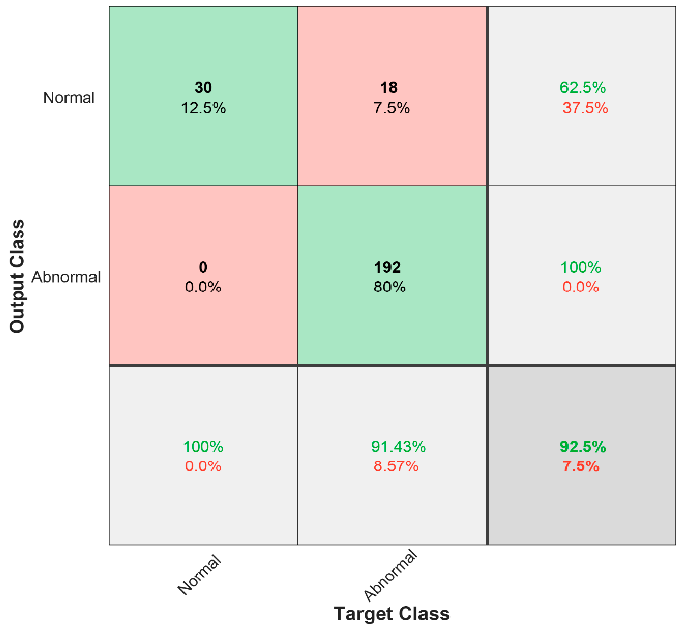
Figure 11. The confusion matrix for two-classes states using PCA-LDA (LLA). Figure 12 also shows the confusion matrix of the presented method for the classification in eight classes. The lower row of the matrix shows the percentages of each disease that were detected correctly (sensitivity). The maximum detection percentage belonged to normal images, and then Huntington and Meningioma came second. However, only 93.3% of Sarcomas were diagnosed correctly. In the end, 92.5% (accuracy) of all images were classified in the proper class, while 7.3% of them could not be recognized and were incorrectly classed. The red cells show incorrect choices or false ones. In each column, the sum of the elements equals the number of images of each disease. For example, for Alzheimer’s (first column), 28 images (from 30) were diagnosed correctly; however, two images were classified into the Alzheimer plus category.